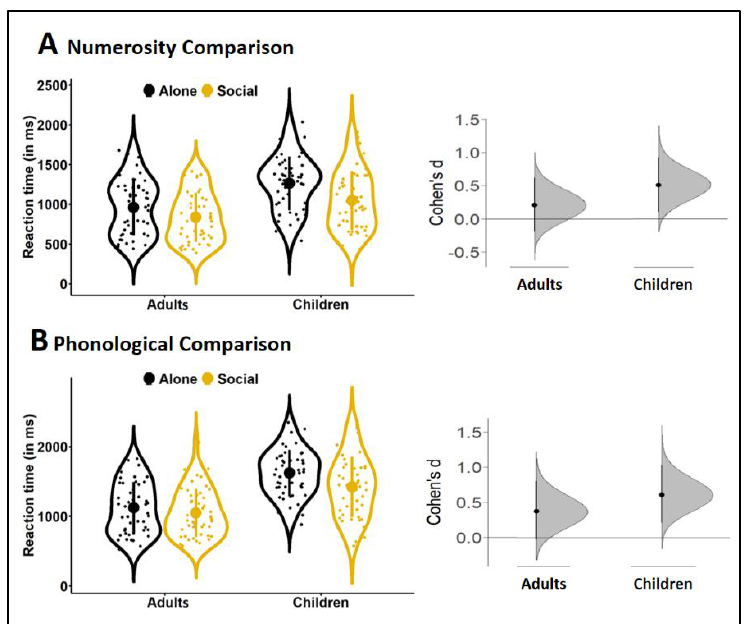
Figure 3. Average performance across difficulty levels for numerosity ( A ) and phonological ( B ) comparisons in adults and children tested without (Alone, black) vs. with (Social, yellow) a peer. For each trial type, reaction times are illustrated by the violin plots (left) with the large dot indicating the mean, the vertical line the standard deviation, the small dots the individual data, and the surrounding shape the density of the data. The corresponding effect sizes (Cohen’s d s ) are presented as bootstrap 95% confidence intervals (right).